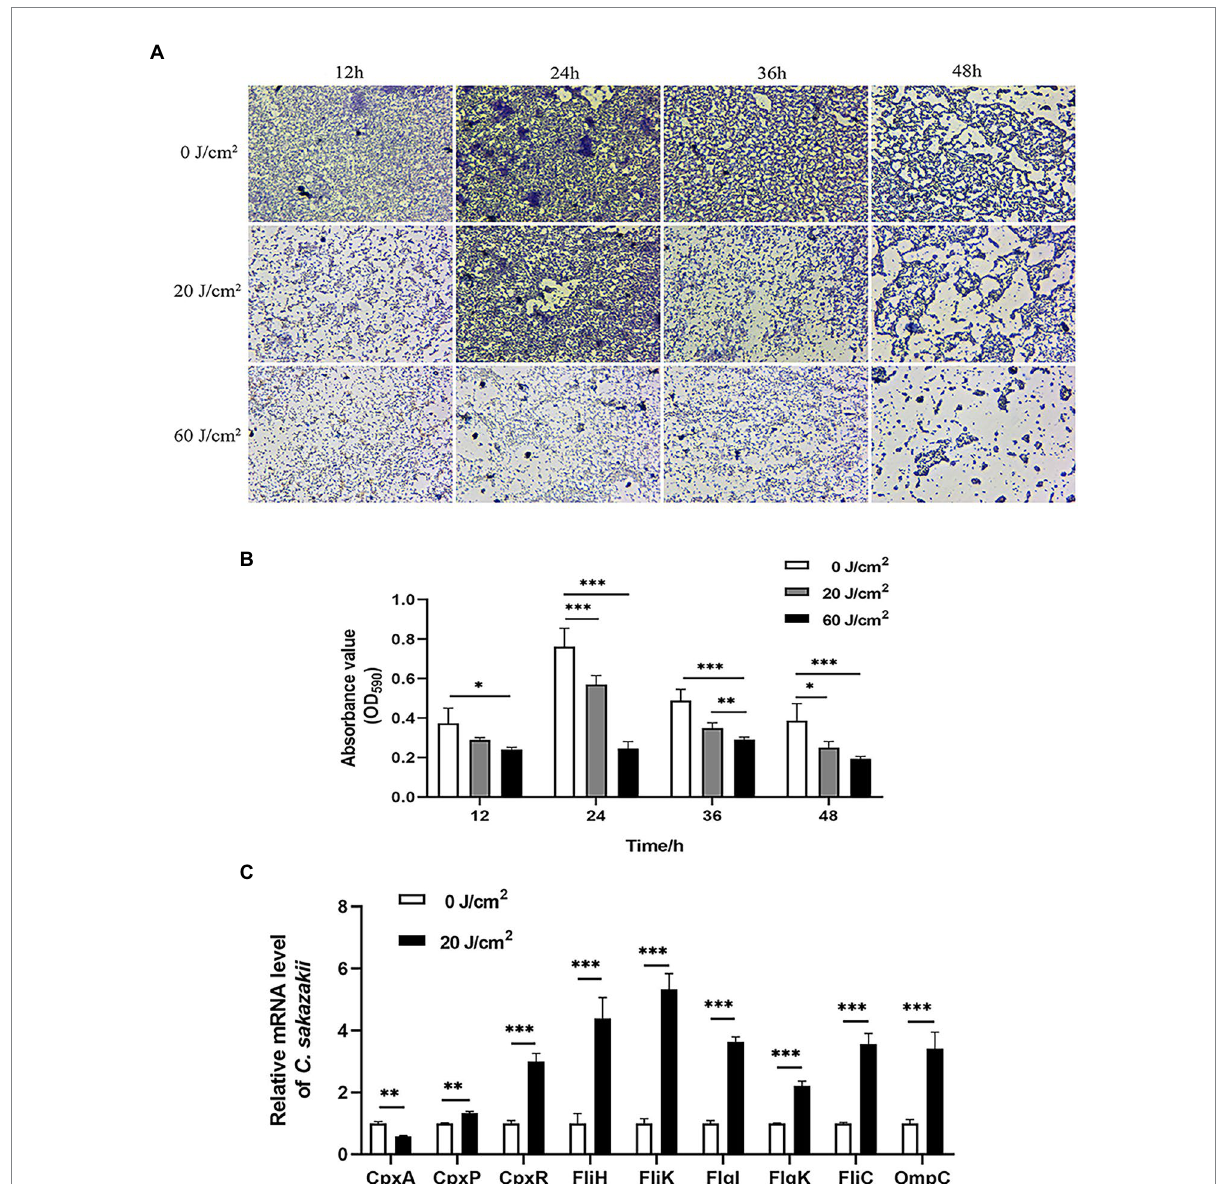
FIGURE 4 Effect of aPDI on the biofilm of C. sakazakii . C. sakazakii was treated with HB illuminated by 460-nm LED (20 or 60 J/cm 2 ) before crystal violet staining.